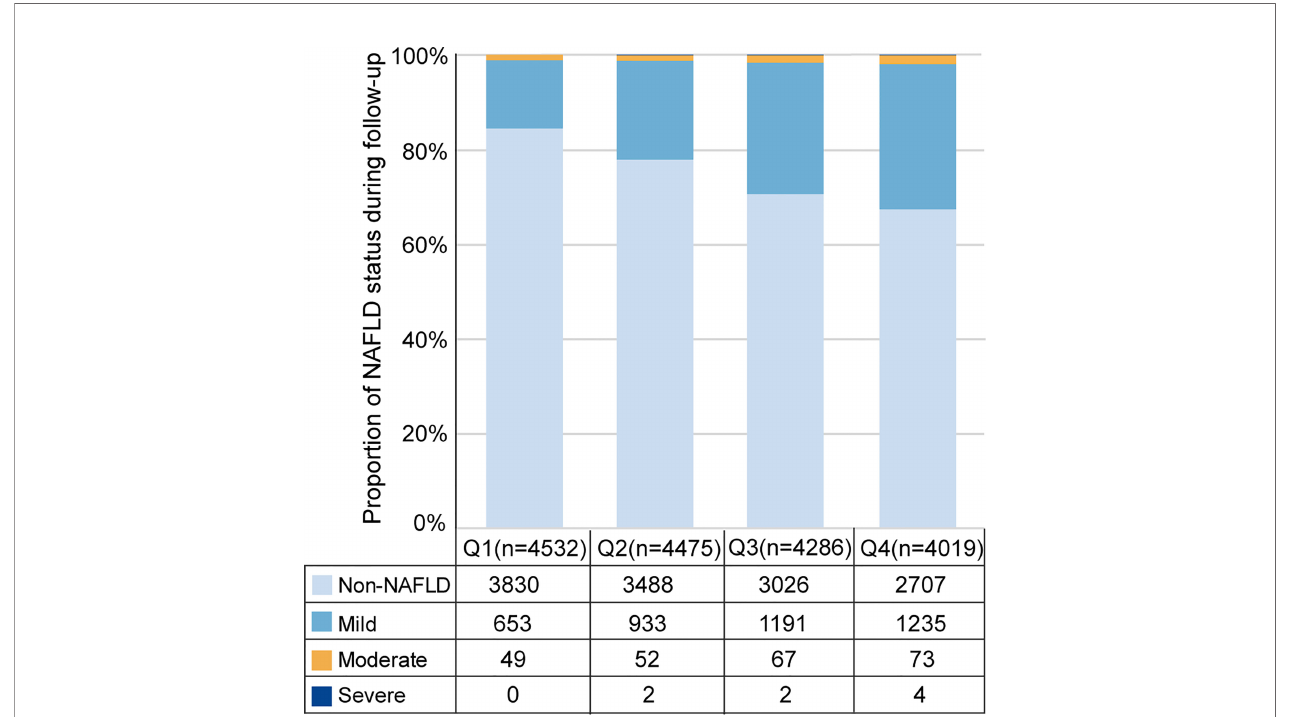
FIGURE 3 | Distribution of incident NAFLD cases and different severity of incident NAFLD cases over RBC count quartiles. Q1, Q2, Q3, Q4 represent the lowest quartile, second quartile, third quartile, highest quartile of RBC count respectively.